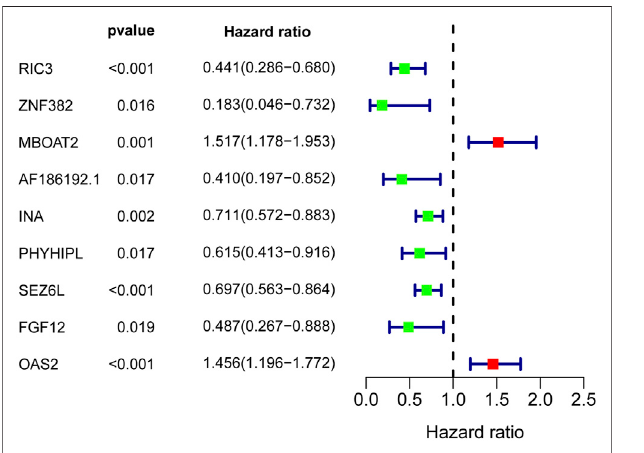
FIGURE 3 | Nine DNA methylation-driven genes were selected by the univariate Cox